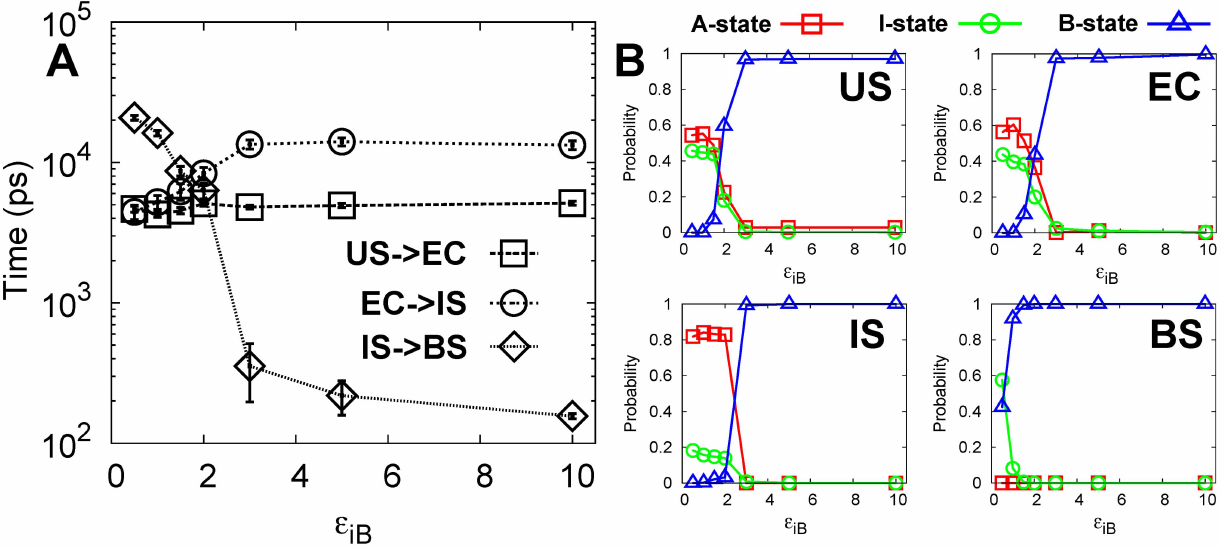
Figure 7. MPT changes with the conformational dynamics. E iB is the strength of the specific native contacts between the LF and F domain in B-state of DPO4. E iB controls the conformational dynamics of DPO4. (A) MPT as a function of E iB . (B) The conformational distribution of the A-, I- and B- state of DPO4 in the US, EC, IS and BS with different E iB . The error bar represents the standard error of the corresponding MPT.